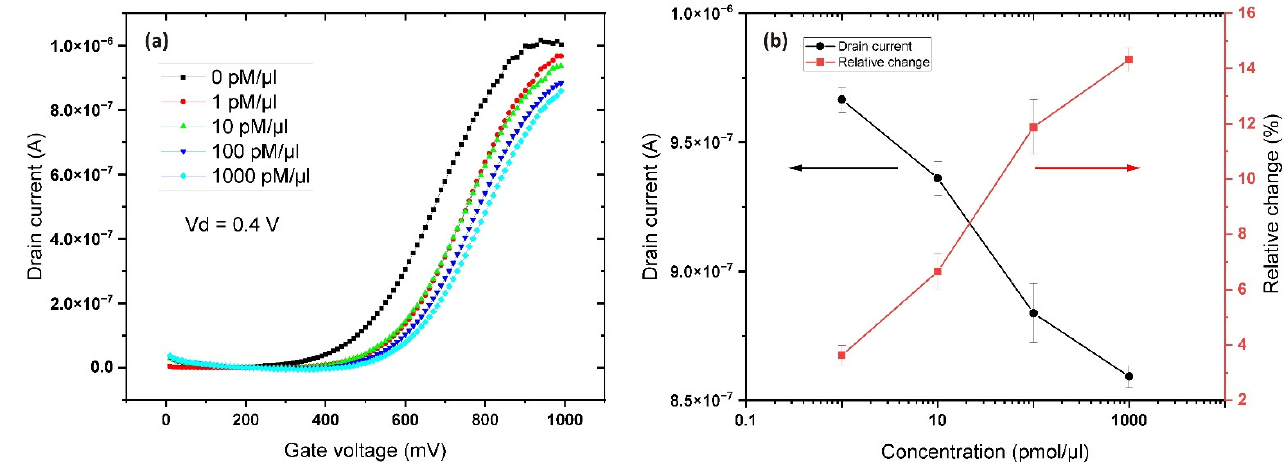
Figure 6. ( a ) Transfer (I d − V g ) curves at 0.4 V drain voltage for aptamer containing analyte at concentrations of 1–1000 pM/ µ L, and ( b ) the relative sensor response level.